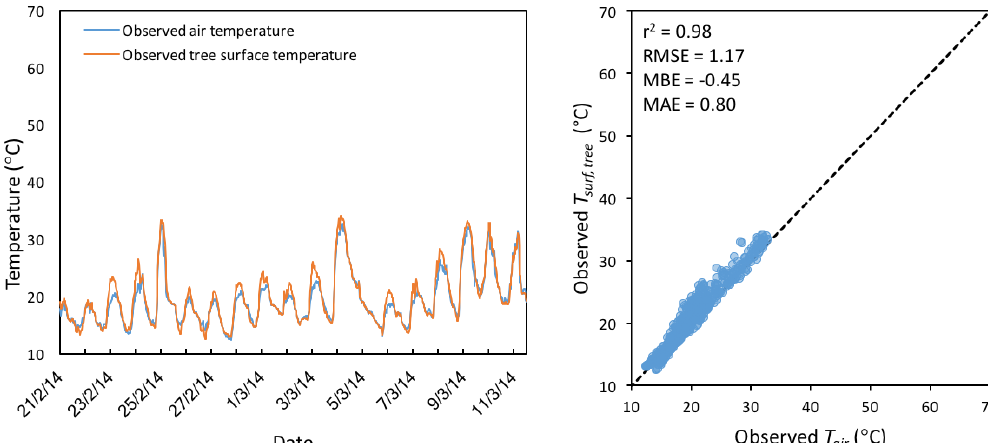
Figure B3. Observed air temperature vs. observed tree T surf